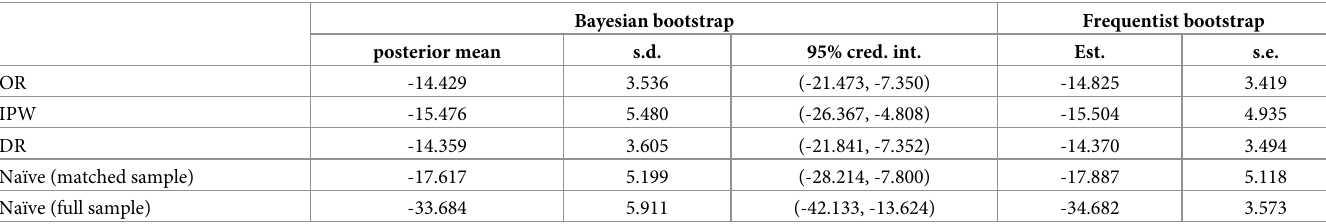
Table 2. Bayesian and frequentist bootstrapped estimates of the average treatment effect.